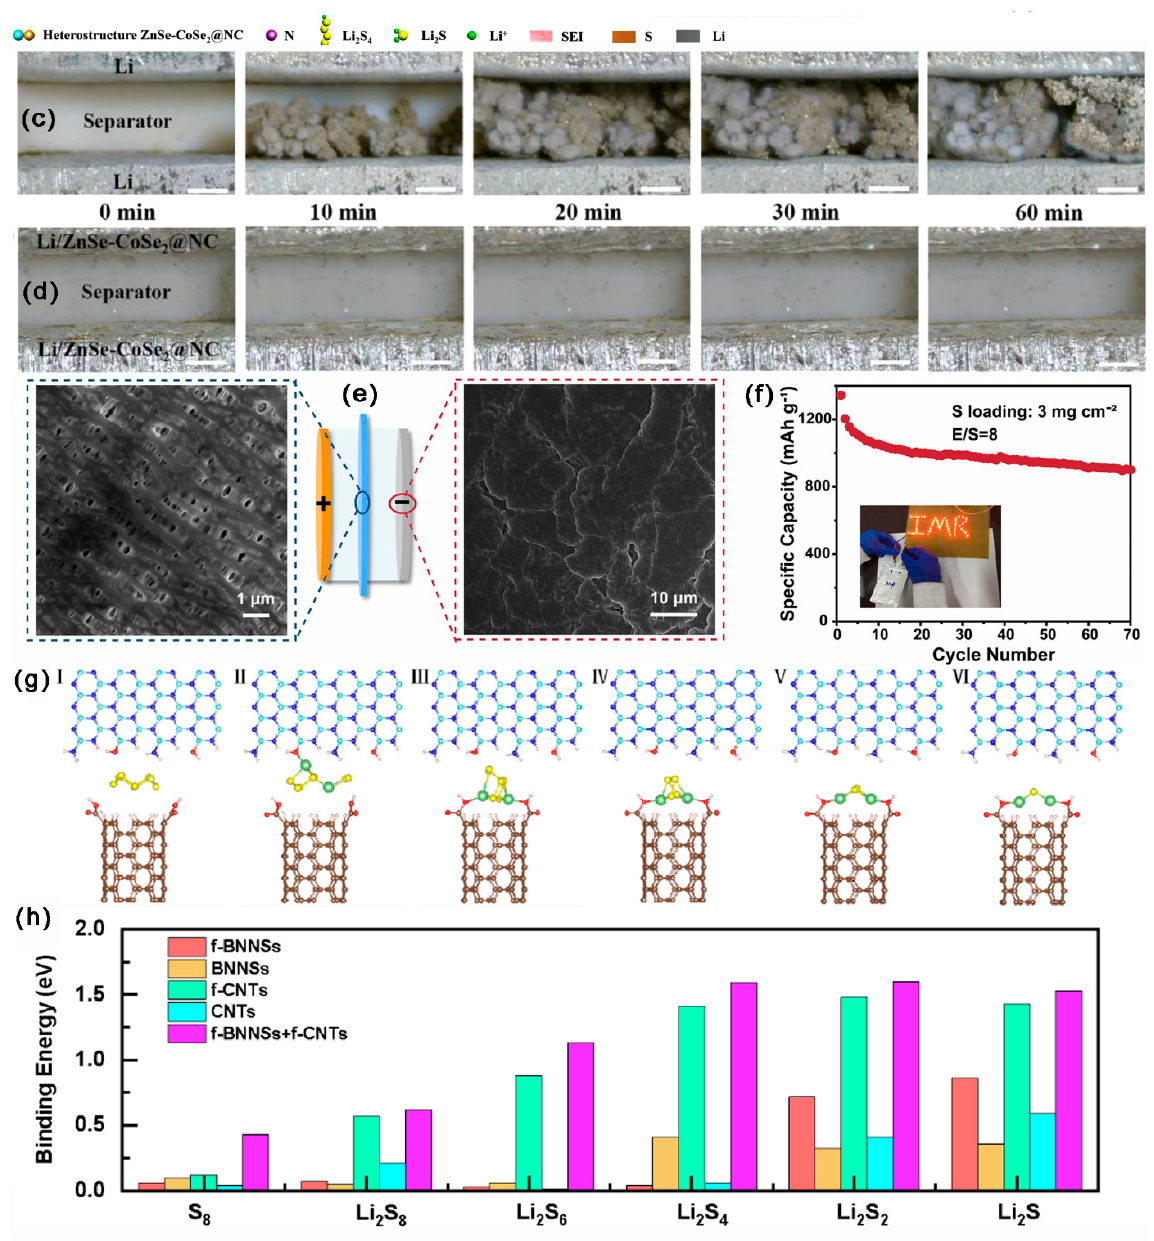
Figure 22. ( a ) The mechanism of S/ZnSe-CoSe 2 @NC||Li/ZnSe-CoSe 2 @NC. ( b ) Binding energy of Li 2 S 6 on ZnSe-CoSe 2 . In situ growth experiments of lithium dendrites of symmetric batteries with ( c ) blank and ( d ) Li/ZnSe-CoSe 2 @NC [153]. ( e ) SEM images of separator with Ni 2 P-HCS-coated after cycling. ( f ) Long cycle of Li-S pouch battery with Ni 2 P-HCS-coated separator at 0.1 C. The inset shows a lithium-sulfur soft pack battery used to light up a LED light [154]. ( g ) f-BNNSs/f-CNTs’ optimal adsorption construction with LiPSs (yellow: S, green: Li, grey: C, blue: B, cyan: N, red: O, white: H). ( h ) Binding energies between S-containing substances and f-BNNSs/f-CNTs [155].